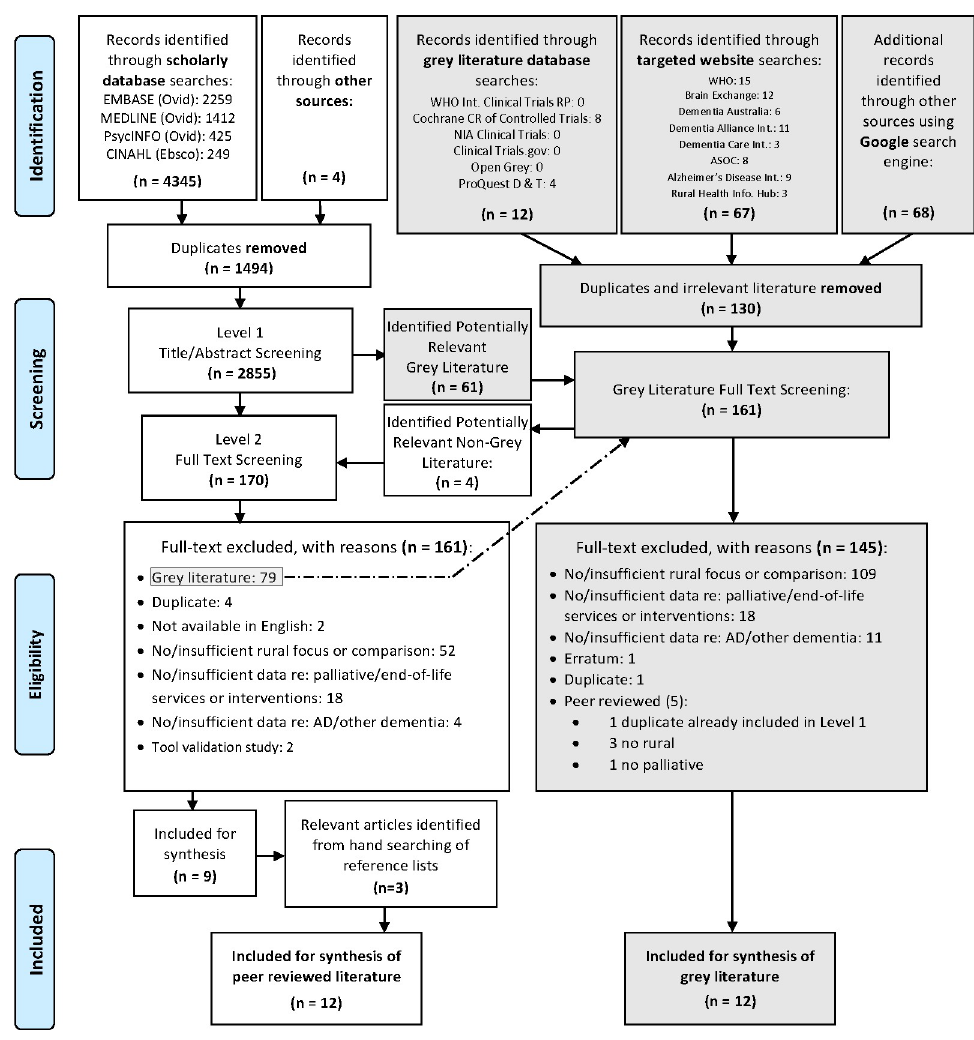
Fig 1. Modified PRISMA flow